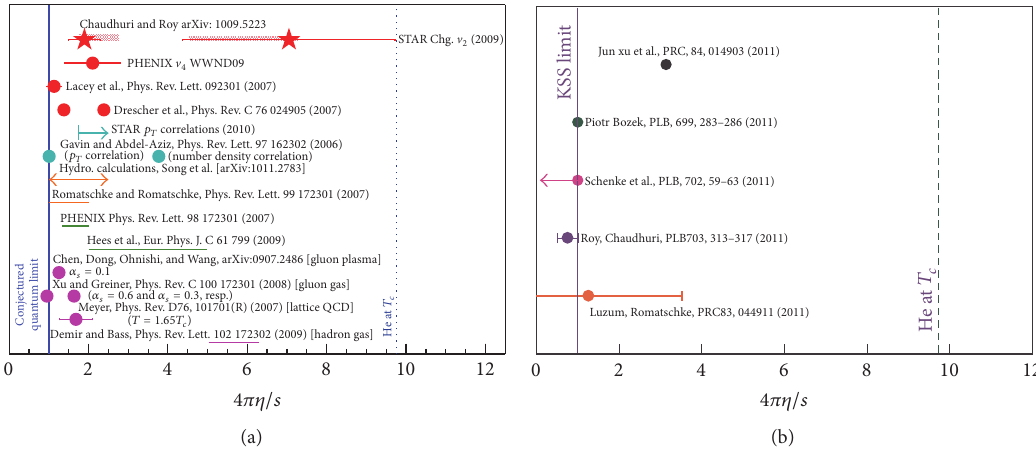
= 200 GeV (a) and for Pb-Pb collision at √𝑠 = 2.76 TeV (b) by different NN NN